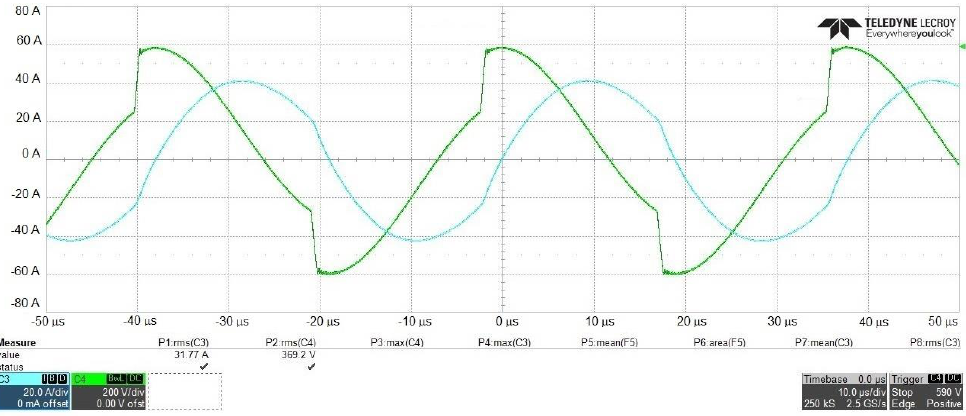
Figure 26. Transmitter coil voltage (C4, green) and current (C3, blue) at 31 kHz.